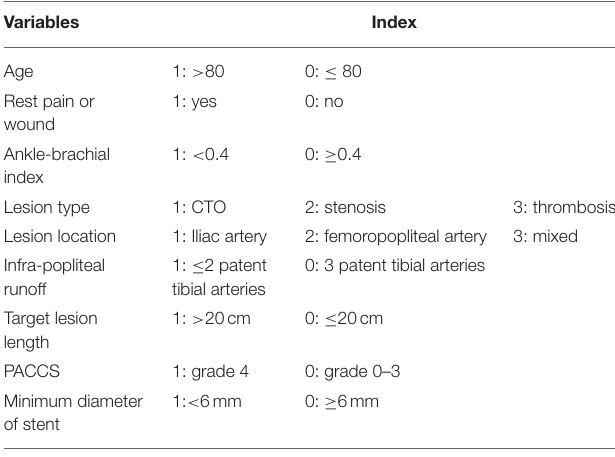
TABLE 3 | Variables for machine learning